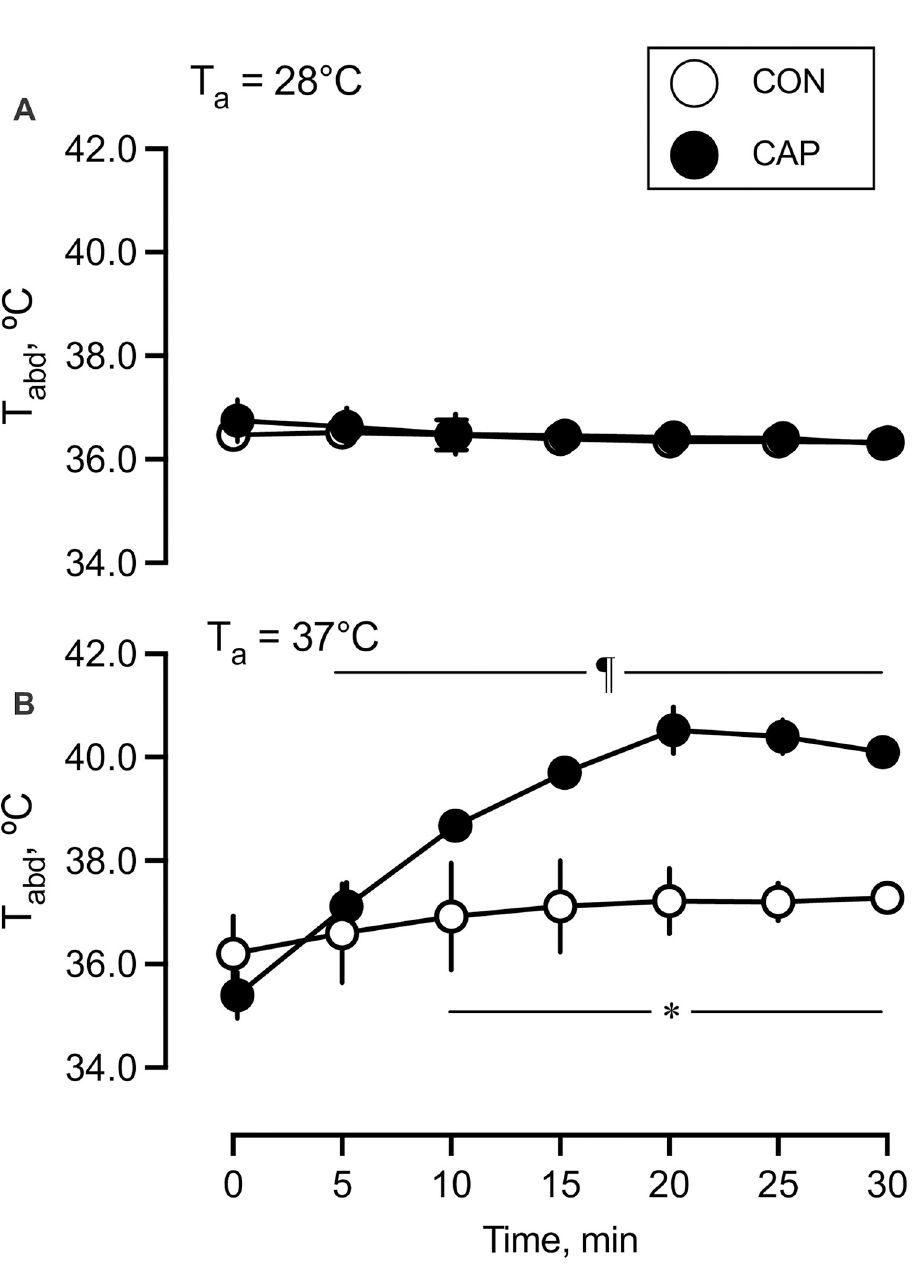
Fig 4. Changes in intra-abdominal temperature (T abd ) during exposure to different ambient temperatures. Changes in T abd during exposure to an ambient temperature of 28˚C (A) and 37˚C (B) in the control (CON) group (open circle; n = 4 and 5, 28˚C and 37˚C, respectively) and capsaicin (CAP) groups (closed circle; n = 4 and 5, 28˚C and 37˚C, respectively). Values are presented as means ± standard deviations (SD). ¶Significant difference compared to the value at 0 min. � Significant difference between the CON and CAP groups, P <